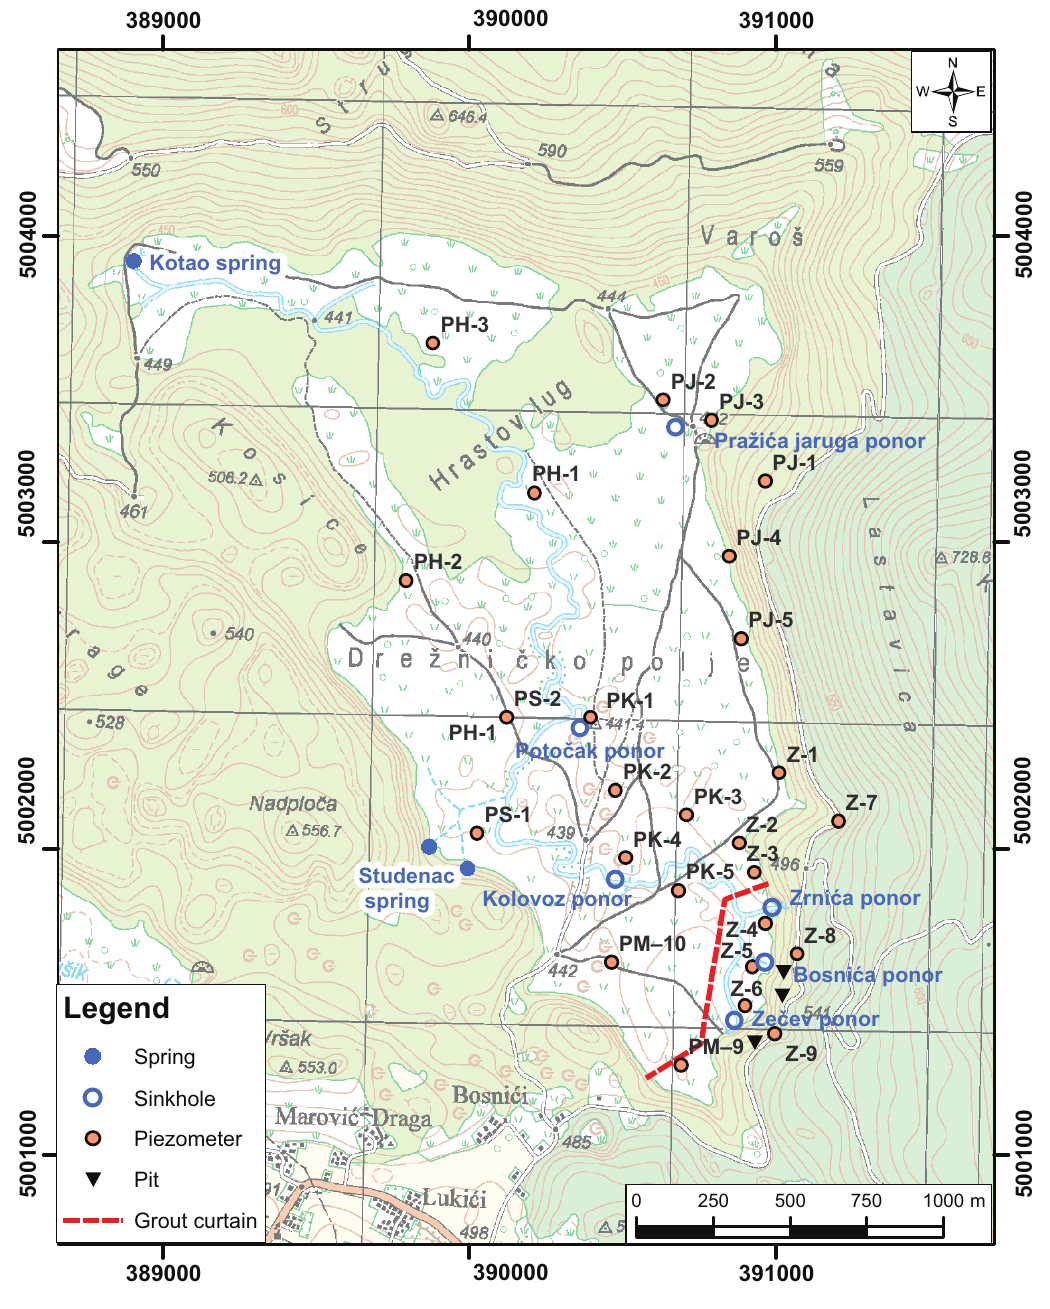
Figure 4. Location of the Drežniˇcko karst polje with with existing hydrogeological objects, piezometers and a designed grout